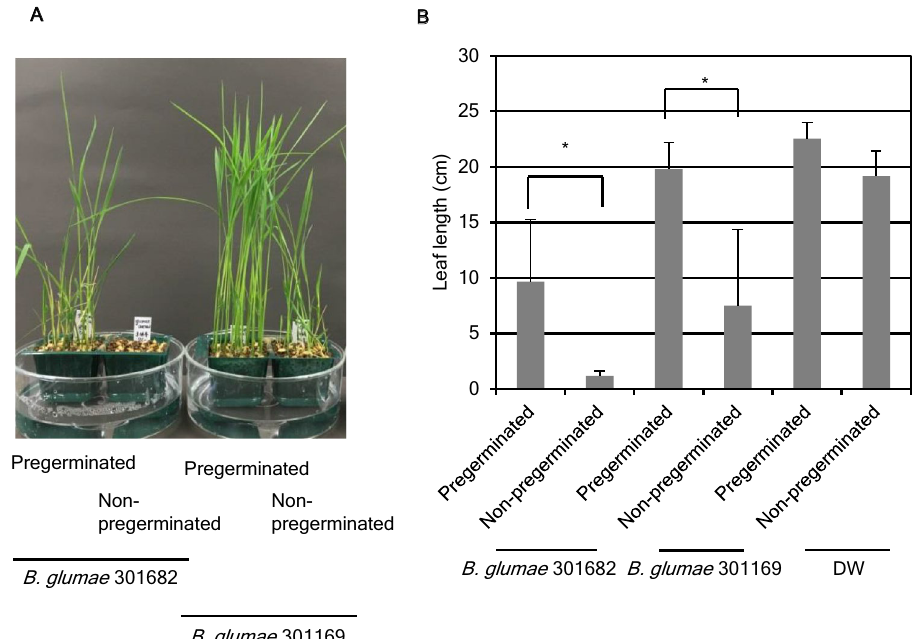
Figure 1. Pregerminated rice seeds were more tolerant to B. glumae infection than non-pregerminated ones. Pregerminated and non-pregerminated rice seeds were inoculated with the suspension of B. glumae 301169 and B. glumae 301682 under reduced pressure. ( A ) Photographs of the seedlings at 8 dpi. ( B ) The leaf length of the seedlings were measured at 8 dpi (n = 25). Statistical significance was subsequently determined through Student’s t-test, * p < 0.0001. Results are representative of four